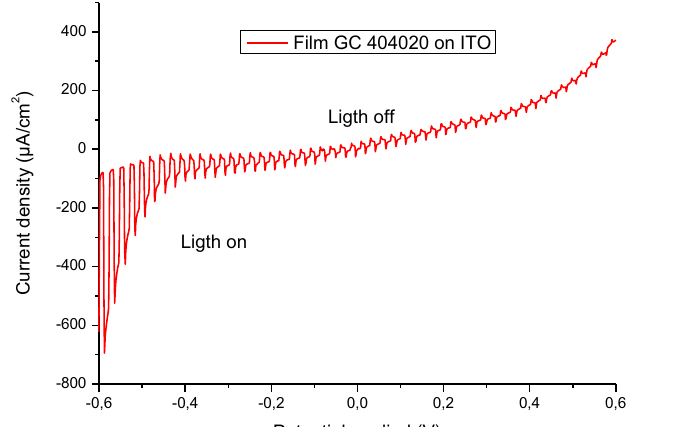
Fig. 3. Photo-electro-chemical measurement showing the dark and light current-voltage characteristics of GC 404020 thin fi lm, indicating clearly it is a p-type semi-conductor.